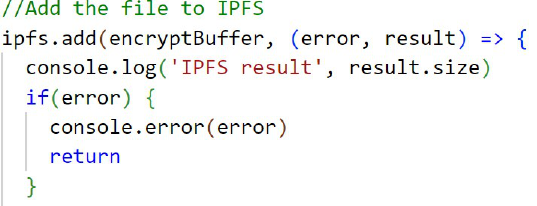
Figure A6. File upload to IPFS.